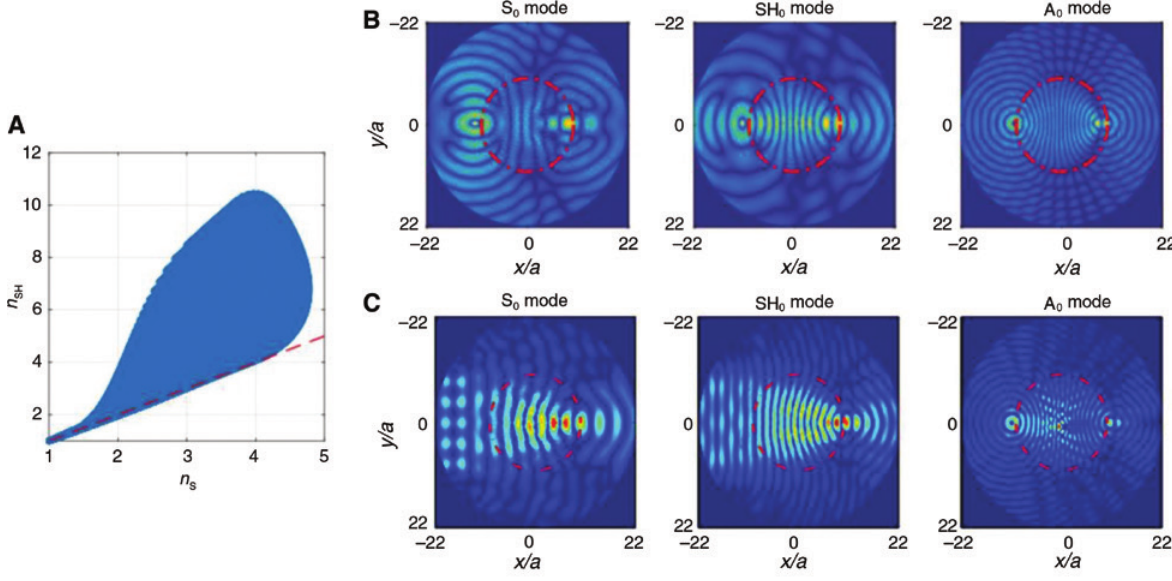
Figure 9: Multimodal GRIN devices to fully control all three fundamental Lamb waves. (A) Diagram of all possible values for the effective indexes for ( n , n ) by varying the inner and outer radii of the gold-shell-hole structure. S0 SH0 (B) GRIN Maxwell fish-eye lens designed for all three Lamb modes simultaneously. (C) An advanced multimodal GRIN device works as Luneburg lens for the S and SH modes while as Maxwell fish-eye lens for the flexural mode 0 0